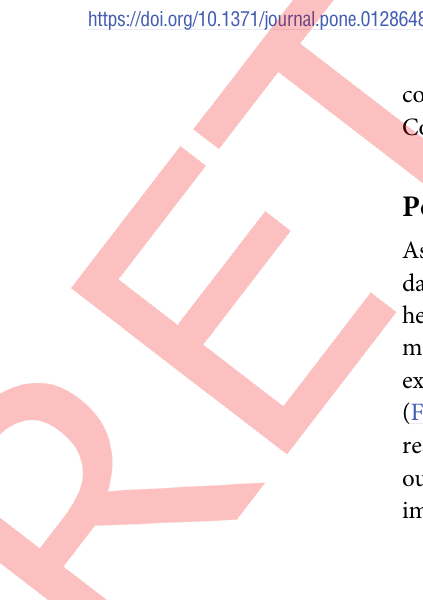
Fig 1. Effect of high-fructose (HFr) supplementation (500 μ M) on markers of oxidative stress and HO-1 and SIRT1 gene expressions in hepatocytes treated with and without CoPP (5 μ M) and SnMP (5 μ M). (A) Isoprostanes level in condition media of hepatocytes (B) heme content measurement in hepatocytes (C) superoxide measurement in hepatocytes. (D) HO-1 mRNA levels (E) SIRT-1 protein levels. (F) Effect of Biliverdin and Tempol on SIRT1 expression in fructose (Fr)-treated hepatocytes. Hepatocytes were treated with biliverdin (10 μ M) and with Tempol (100 μ M) in presence of fructose (500 μ M) for 24 hours. Results are mean ± SE, n = 6/group. � p < 0.05 vs CTR; # p < 0.05 vs HFr, + p < 0.05 vs HFr+CoPP. Fig 1E, F Actin panels and Fig 1E SIRT1 panel are excluded from this article’s CC-BY license. See the accompanying retraction notice for more